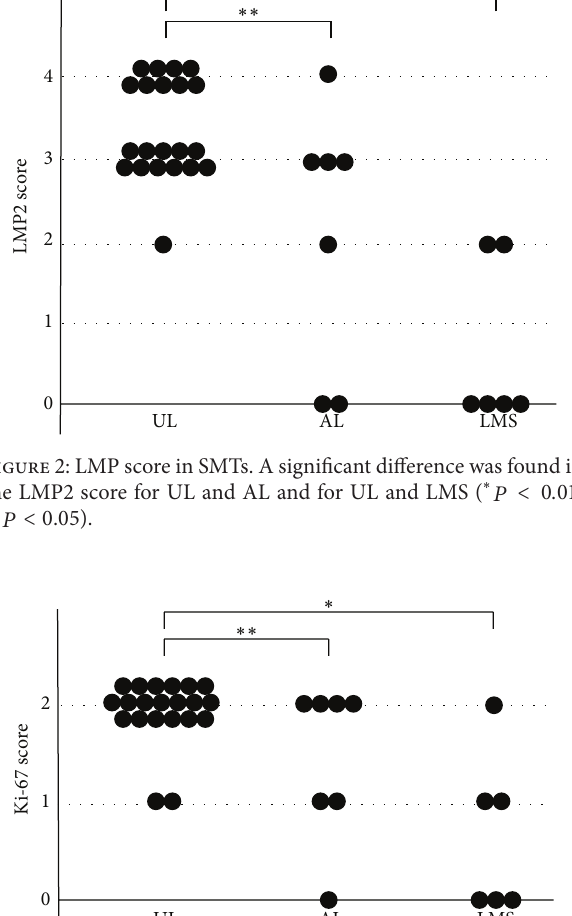
Figure 3: Ki-67 score in SMTs. A significant difference was found in the LMP2 score for UL and AL and for UL and LMS ( ∗ 𝑃 < 0.01 , ∗∗ 𝑃 < 0.05 ).